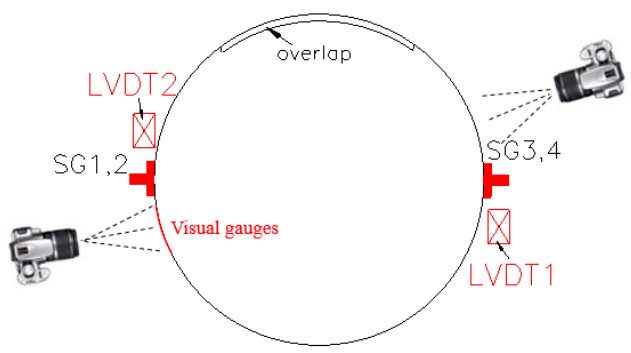
Figure 4. Location of cameras, foil strain gauges and LVDTs in the verification test.